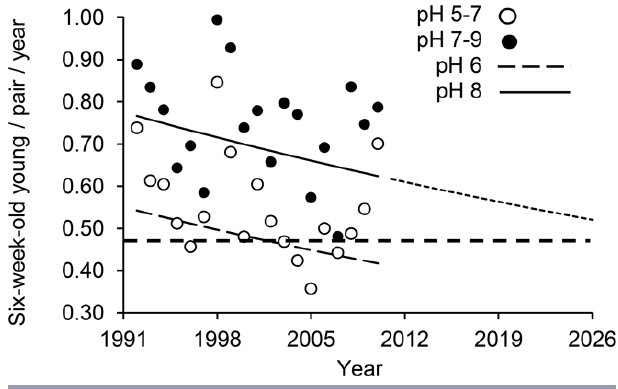
Fig. 6 . Reproductive success of Common Loons ( Gavia immer ) across southern Canada as a function of pH and year between 1992 and 2010, with projections into the future. Shown are model-averaged predictions from the second best model from the second part of the analysis (Table 3), with pH held at two selected values and log lake area held at its median value. Means are shown across each of several arbitrary bin classes (dots) for two different pH categories to illustrate model fit, but be aware that these means were not the data used to fit the model. The horizontal dashed line is the minimum estimated number of six-week-old young per pair per year (0.48) required to offset adult and juvenile mortality (Evers